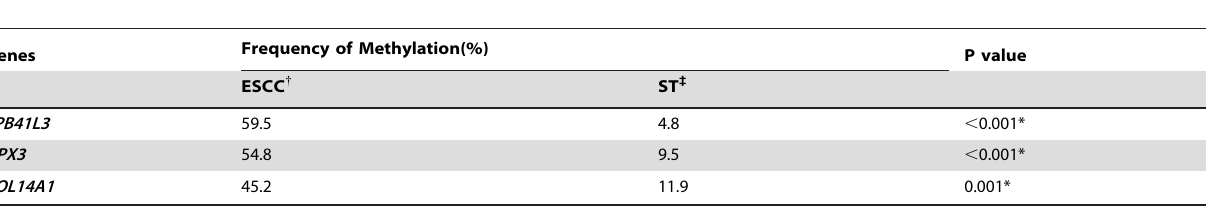
Table 3. Frequency of Promoter Methylation for Individual Genes in Esophageal Squamous Cell Carcinoma Patients (n=84).